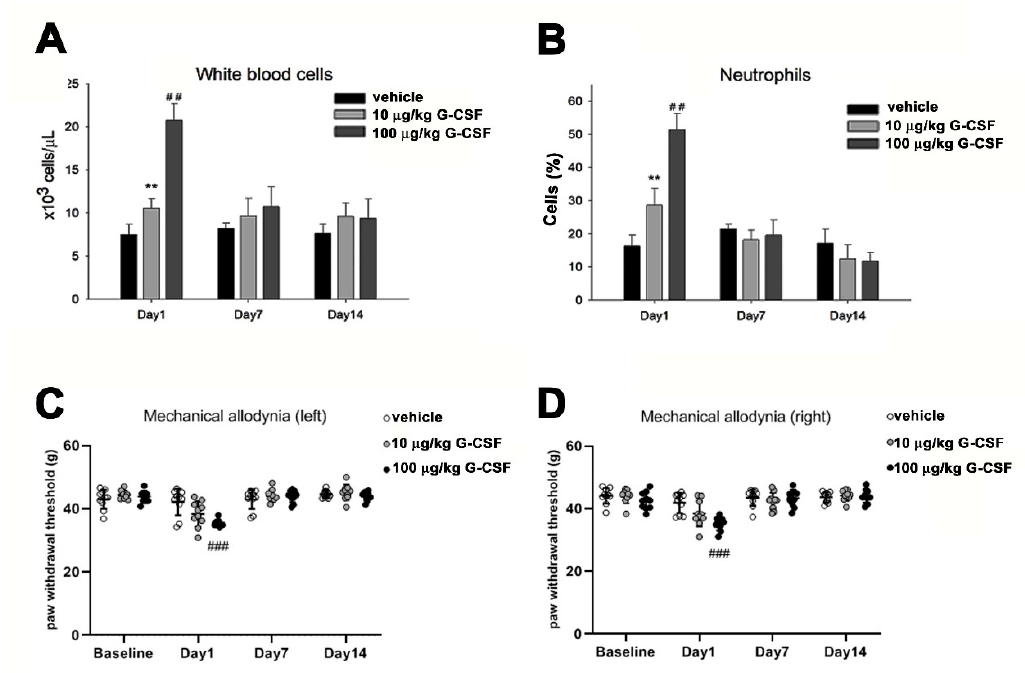
Figure 4. Effect of exogenous G-CSF on wildtype rat behavior and blood cell numbers. ( A ) Histograms showing the results of white blood cell analysis (×10 3 cells/ μ L) in the vehicle (normal saline solution) group, G-CSF (10 μ g/kg) group and G-CSF (100 μ g/kg) group. White blood cell analysis was performed with a Bayer ADVIA 2120 hematology analyzer. ** p < 0.01, G-CSF (10 μ g/kg) group compared with the vehicle group; ## p < 0.01, G-CSF (100 μ g/kg) group compared with the vehicle group. ( B ) Histograms showing the results of neutrophil analysis in the 3 groups of rats. Neutrophil analysis was performed with a Bayer ADVIA 2120 hematology analyzer. ** p < 0.01, G-CSF (10 μ g/Kg) group compared with the vehicle group; ## p < 0.01, G-CSF (100 μ g/Kg) group compared with the vehicle group. Left ( C ) and right ( D ) paw withdrawal test for mechanical allodynia. Left and right feet of pain behavioral responses of the 3 groups of rats (n = 10 per group). Mechanical allodynia of both feet was assessed using a DPA. ### p < 0.001, G-CSF (100 μ g/Kg) group, compared with the vehicle group.